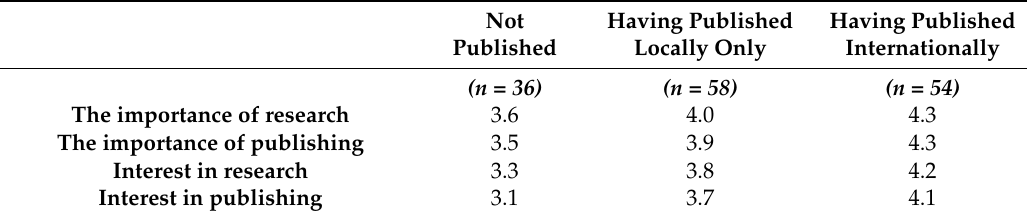
Table 5. Mean scores according to publication